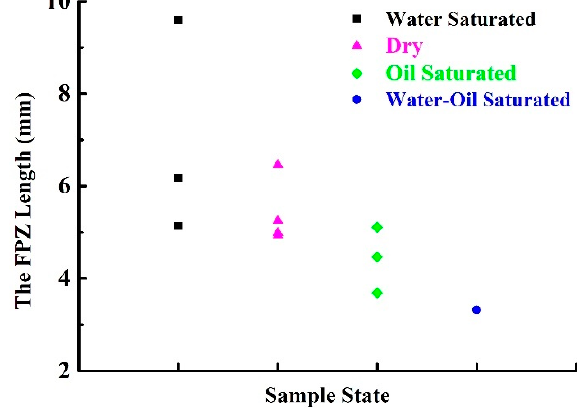
Figure 8. The fracture process zone (FPZ) length vs. sample state.